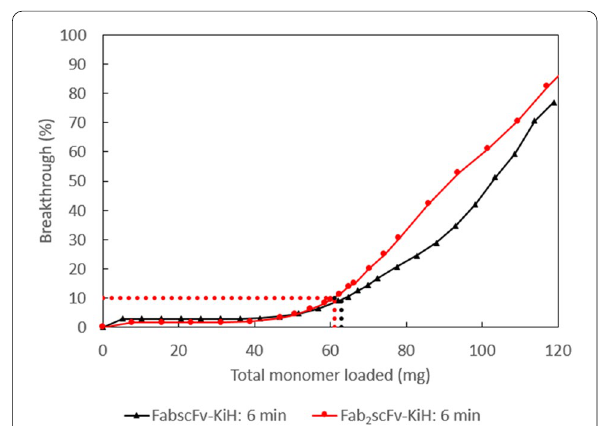
Fig. 4 Breakthrough curve study at 6-min residence time for FabscFv-KiH (black) and Fab 2 scFv-KiH